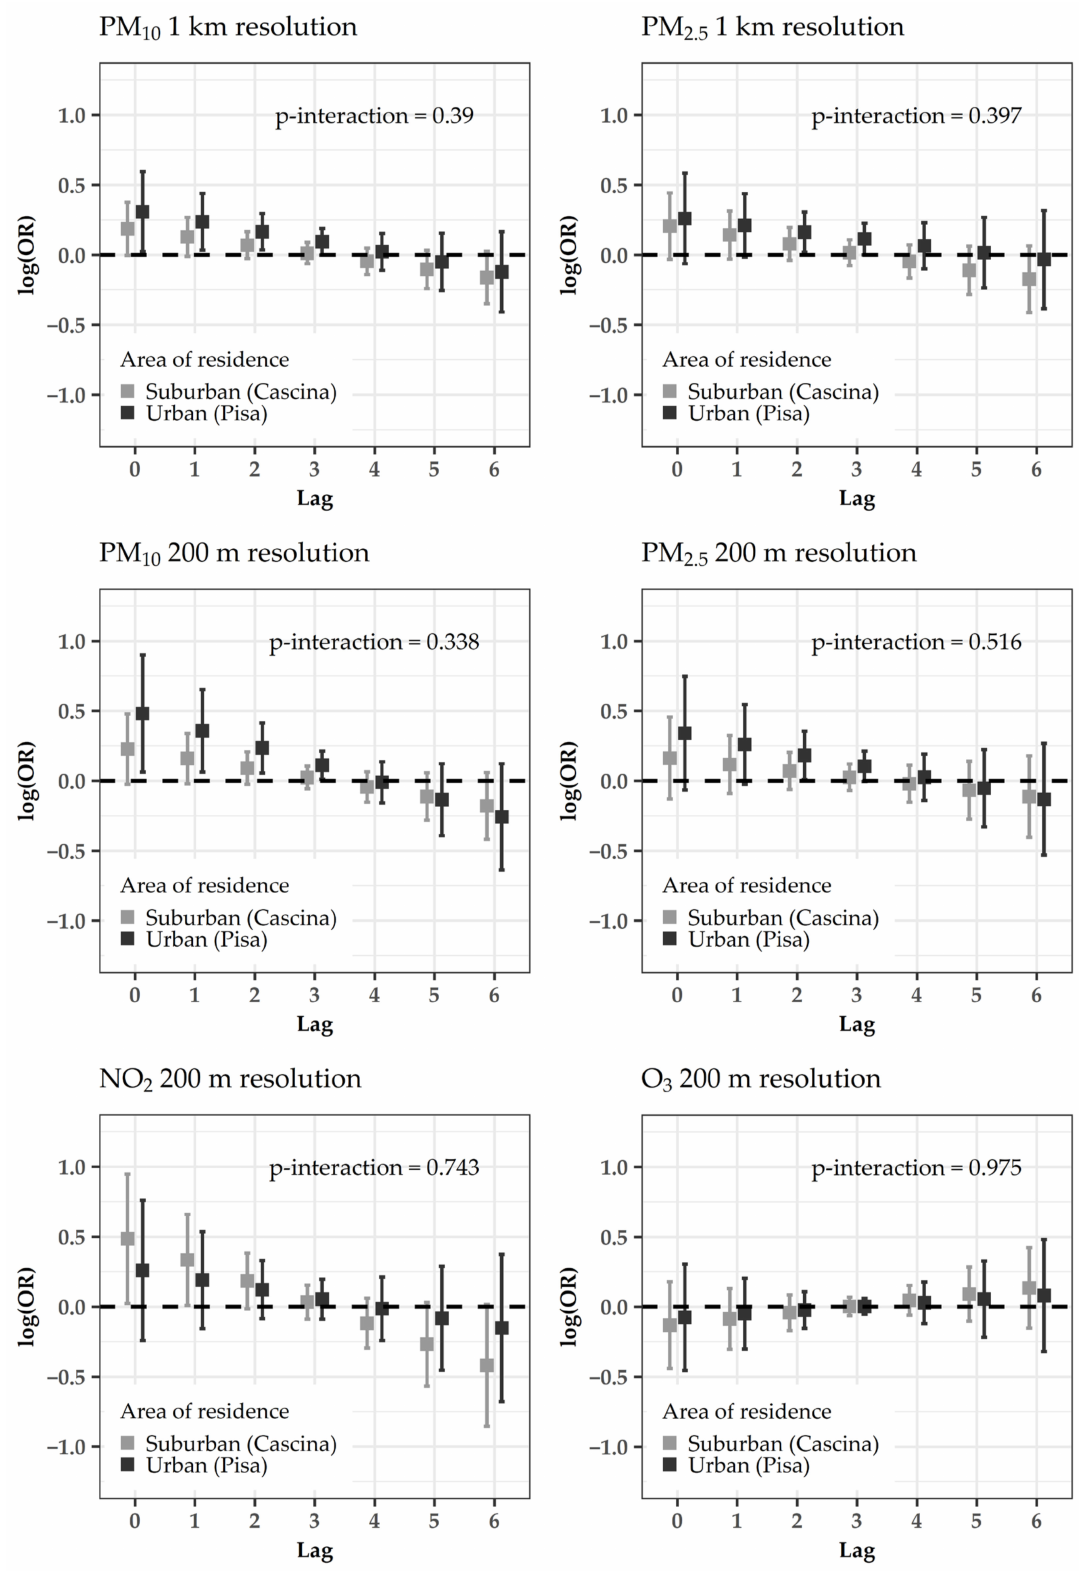
Figure 3. Acute effects of estimated pollution levels (sub-period 2013–2015) on the risk of cardiovascular hospitalizations: log-odds ratios (OR) and 95% confidence intervals for the conditional logistic regression models with distributed lags, stratified by area of residence. p -values for interactions are